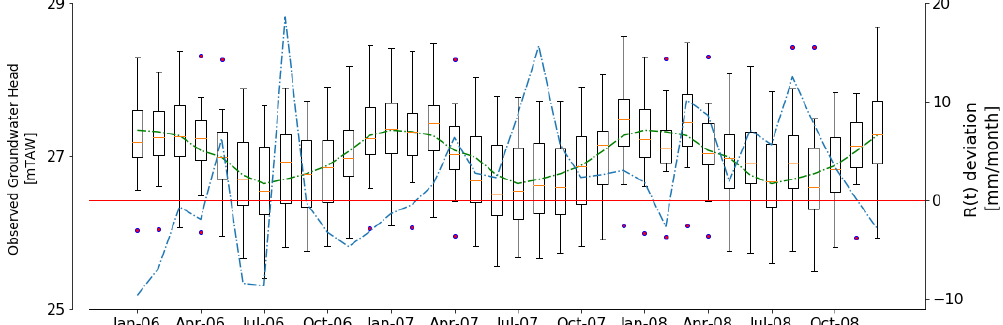
Figure 16. Observed groundwater head distribution collected from 14 observation wells (boxplot with monthly time step), long-term (2003– 2013) average monthly observed groundwater head (dotted green line) and groundwater recharge deviation from threshold value (dotted blue line) between 2006 and 2008. These observation wells are mainly found in the delineated wetland area (Fig.